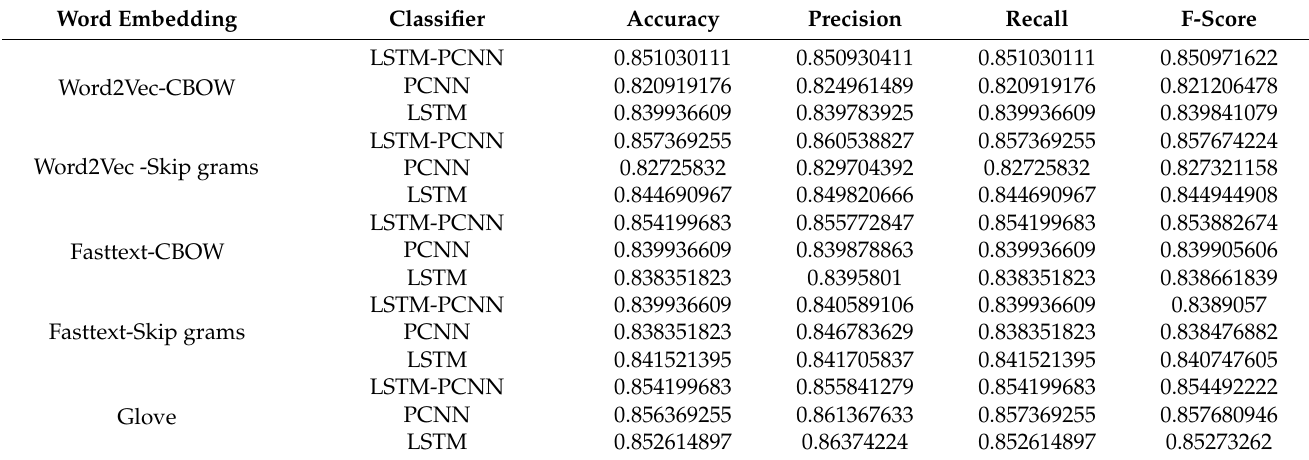
Table A1. The Median Values obtained using Various Classifiers with One Dense Layer.